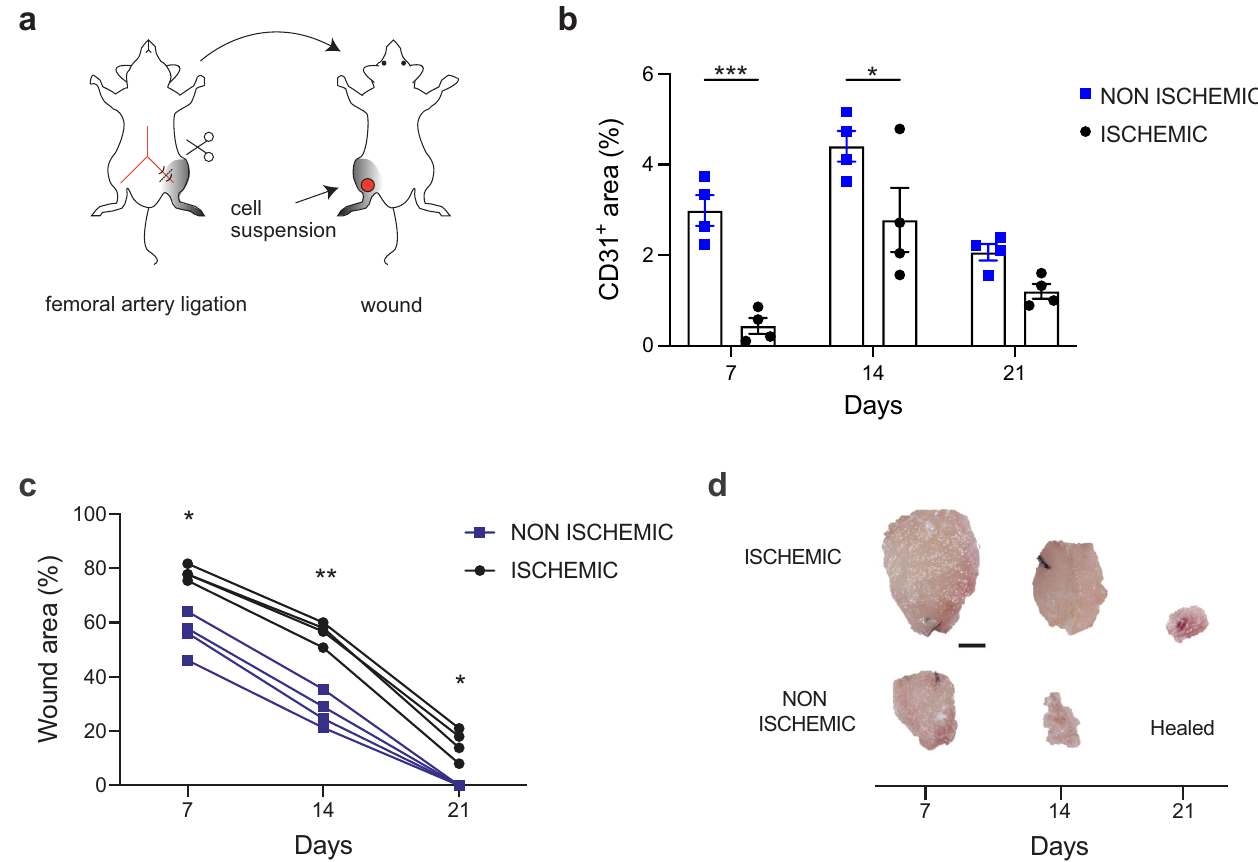
Fig. 1 A new in vivo model of the ischemic wound. a Schematic representation of a new murine model of chronic ischemic wound. The left femoral artery is ligated to induce hindlimb ischemia. The animal is then turned upside down and a full-thickness skin punch wound is created above the ischemic muscle, on the same side. b Quanti fi cation of CD31 + area in ischemic and nonischemic wounds at the indicated time points. c Quanti fi cation of wound area in ischemic and nonischemic limbs, treated with an INTEGRA scaffold, at the indicated time points. d Representative images of wounds as quanti fi ed in panel c . Data are shown as individual values in ( b , c ); n = 4 per group. Scale bar in ( d ), 1 mm. Statistical signi fi cance was determined using two-way ANOVA for repeated measurements in ( b , c ). * P < 0.05, ** P < 0.01, *** P <